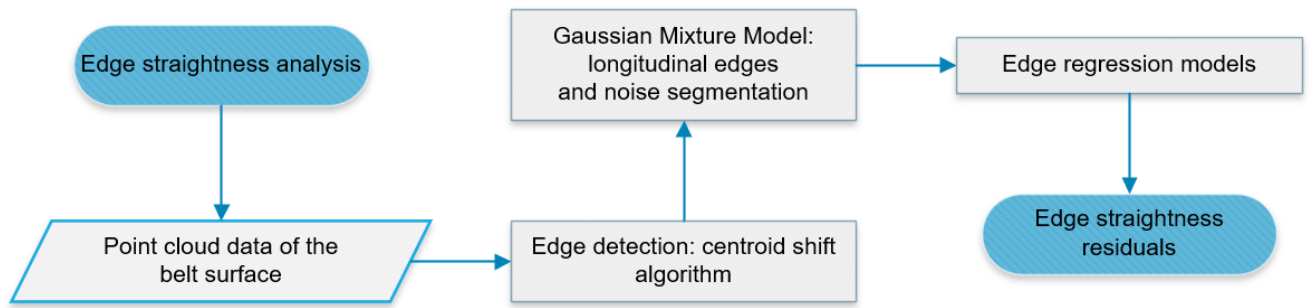
Figure 5. Workflow of belt edge detection and their straightness